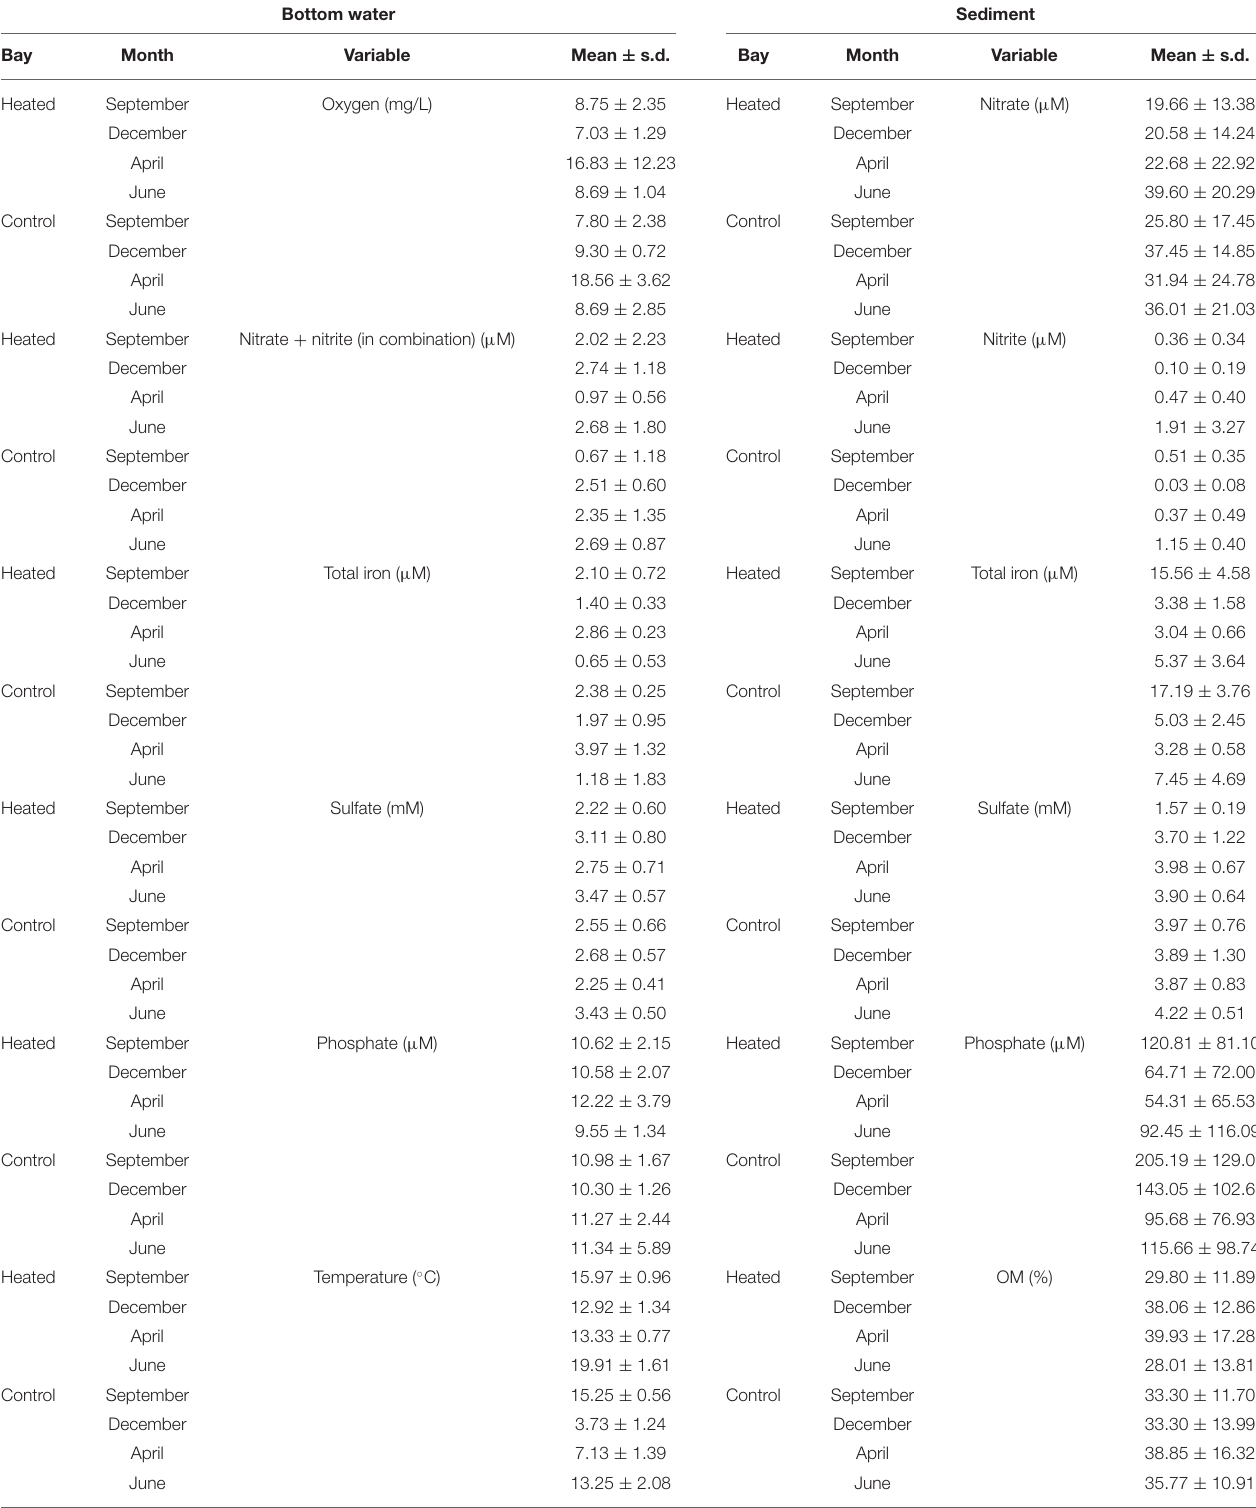
TABLE 2 | Environmental variables. Bottom water Sediment Bay Variable Mean ± s.d. Bay Month Variable Mean ±